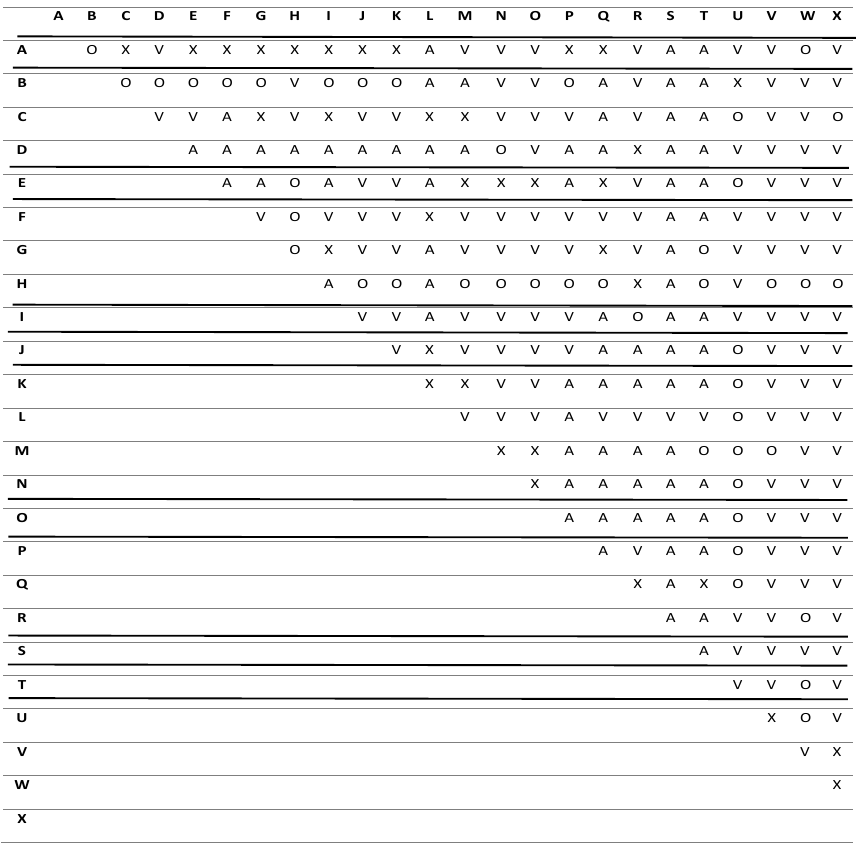
Table 1. Structural self-interaction